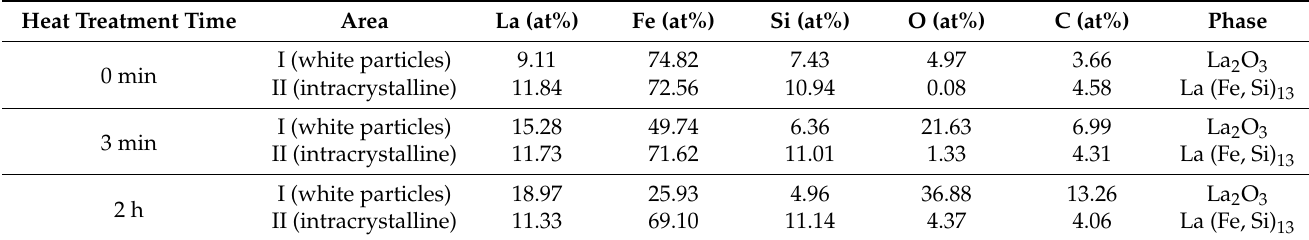
Table 4. Inside grains and white grains the EDS analysis of LaFe 11.5 Si 1.5 C 0.2 ribbons at a wheel speed of 35 m/s annealed at 1273 K for different times.